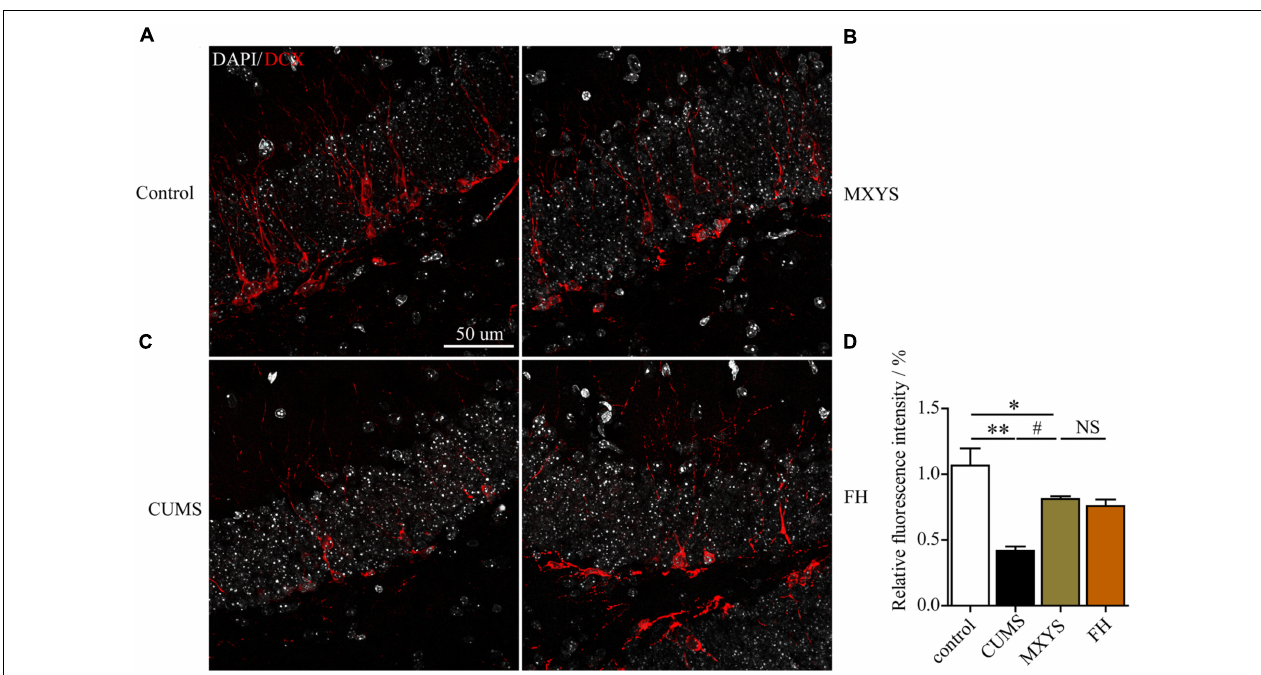
FIGURE 5 | MXYS improved the hippocampal DCX-positive neurons survival against the CUMS treatment. Representative micrographs of IF staining for the DCX-positive cells (red, scale bar = 50 µ m, 400 × magnification) in the hippocampal DG region of 4 groups ( A , Control group; B , MXYS treatment group; C , CUMS group; D , FH treatment group). Compared with the control group, the CUMS-exposed mice displayed down-regulation of DCX expression in the hippocampus, which were improved by the MXYS and FH administration. Data are presented as means ± SEM. ∗ P < 0.05, ∗∗ P < 0.01 versus control group; # P < 0.05 versus CUMS group; NS, P >